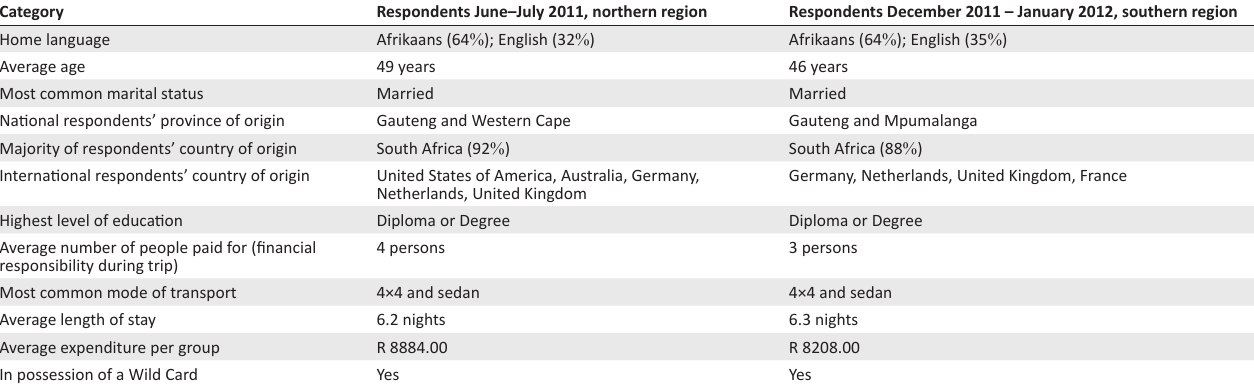
TABLE 1: Comparison of profiles of respondents staying in the northern and southern regions of the Kruger National Park, 2011–2012.